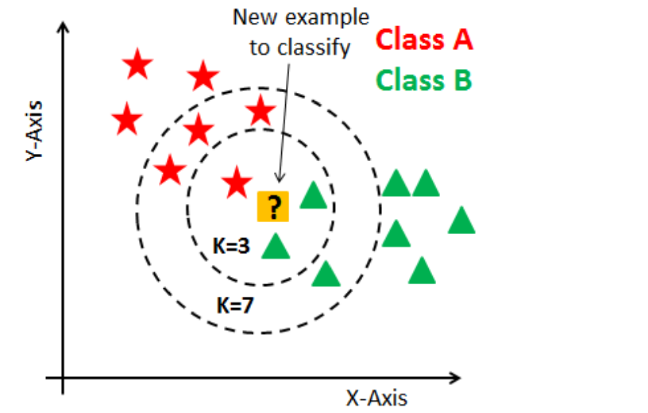
Figure 8. K-nearest neighbor algorithm